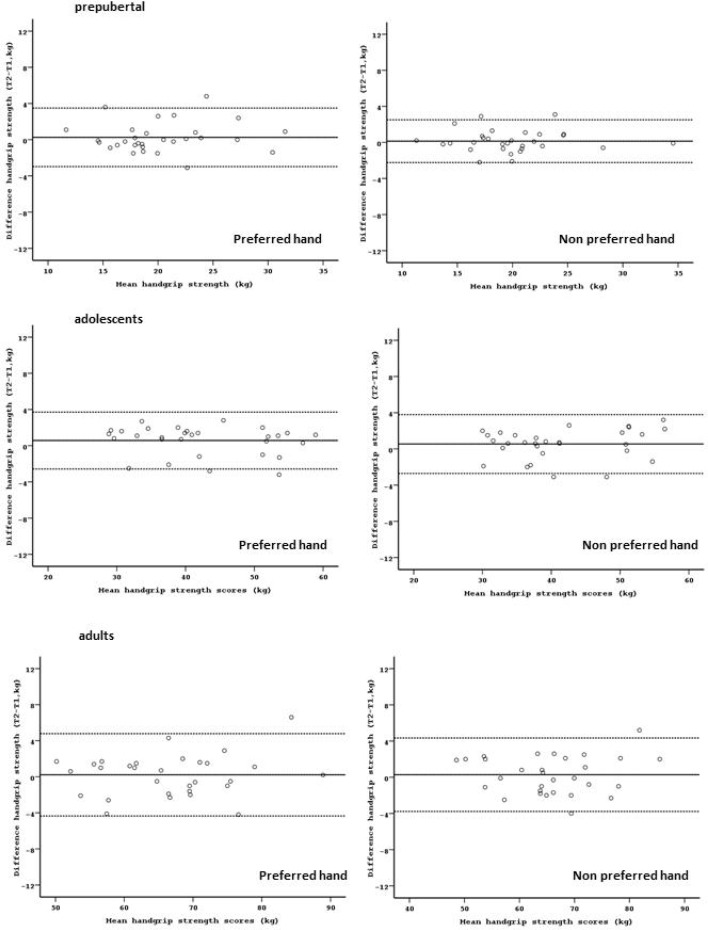
Bland-Altman plots of the handgrip strength test for preferred and non-preferred hand in each age group. The central line characterizes the mean difference between test and retest values; the upper and lower lines characterize the upper and lower 95 % limits of agreement (LOA = inter-trials mean difference ± 1.96SD of the inter-trials difference), respectively